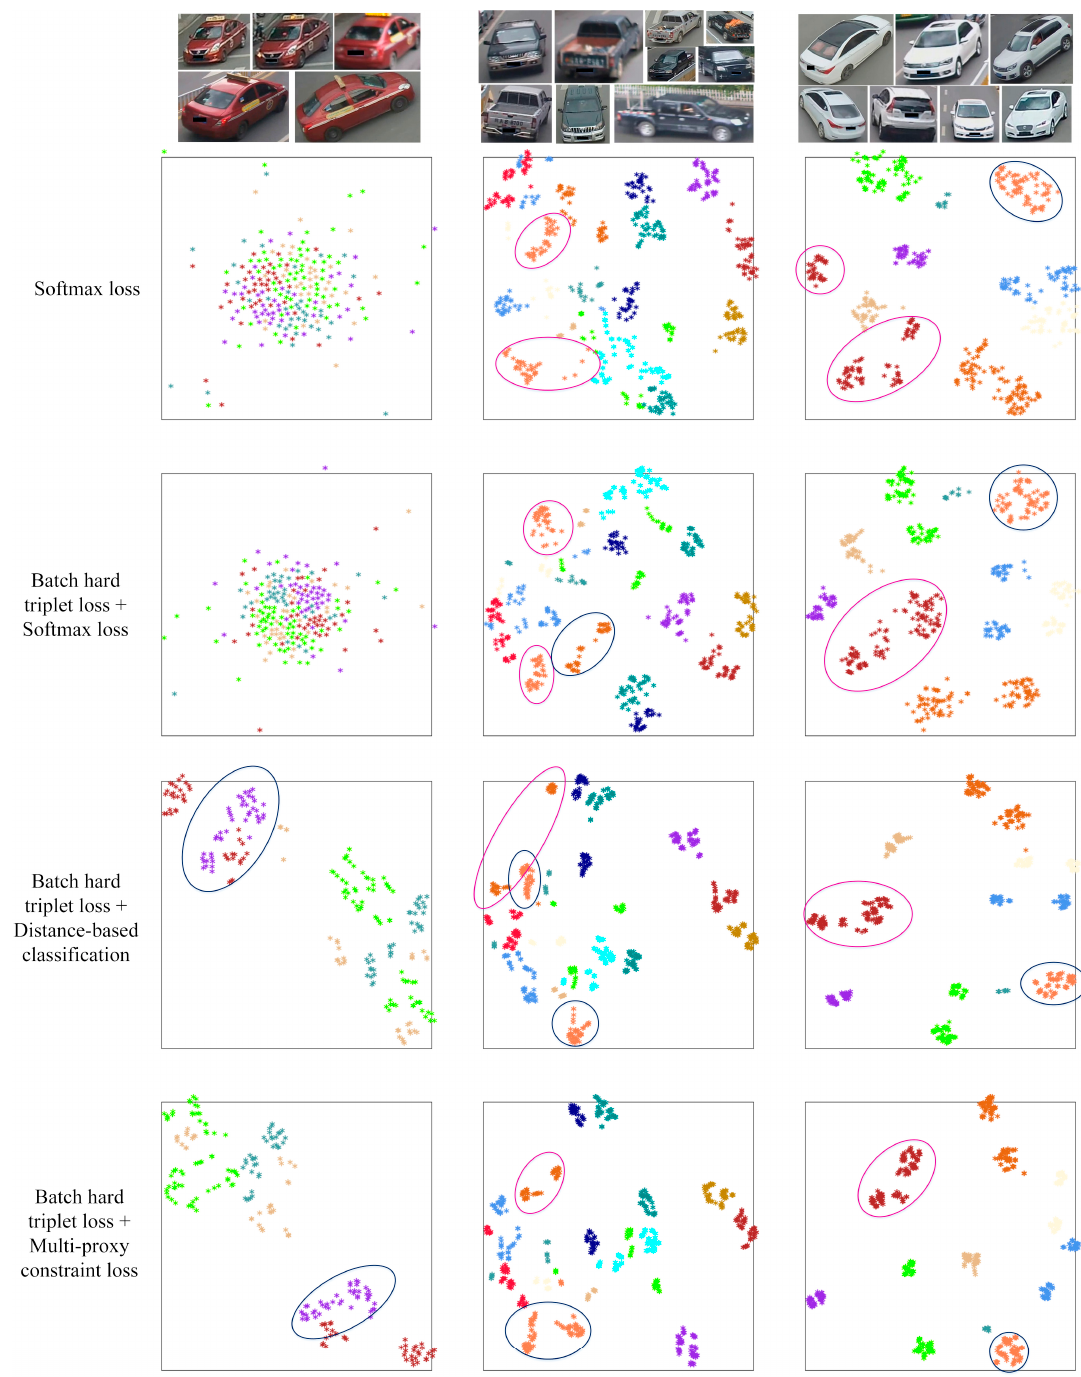
Figure 4. Visualization of the feature distribution by t-SNE on VeRi-776 test dataset. Di ff erent colors represent di ff erent vehicles. We randomly select three sets of similar images for comparison. The last two row shows the results of distance-based classification and multi-proxy constraint loss from top downwards, respectively. Compared with distance-based classification, the multi-proxy constraint loss contributes to a more compact feature embedding space.